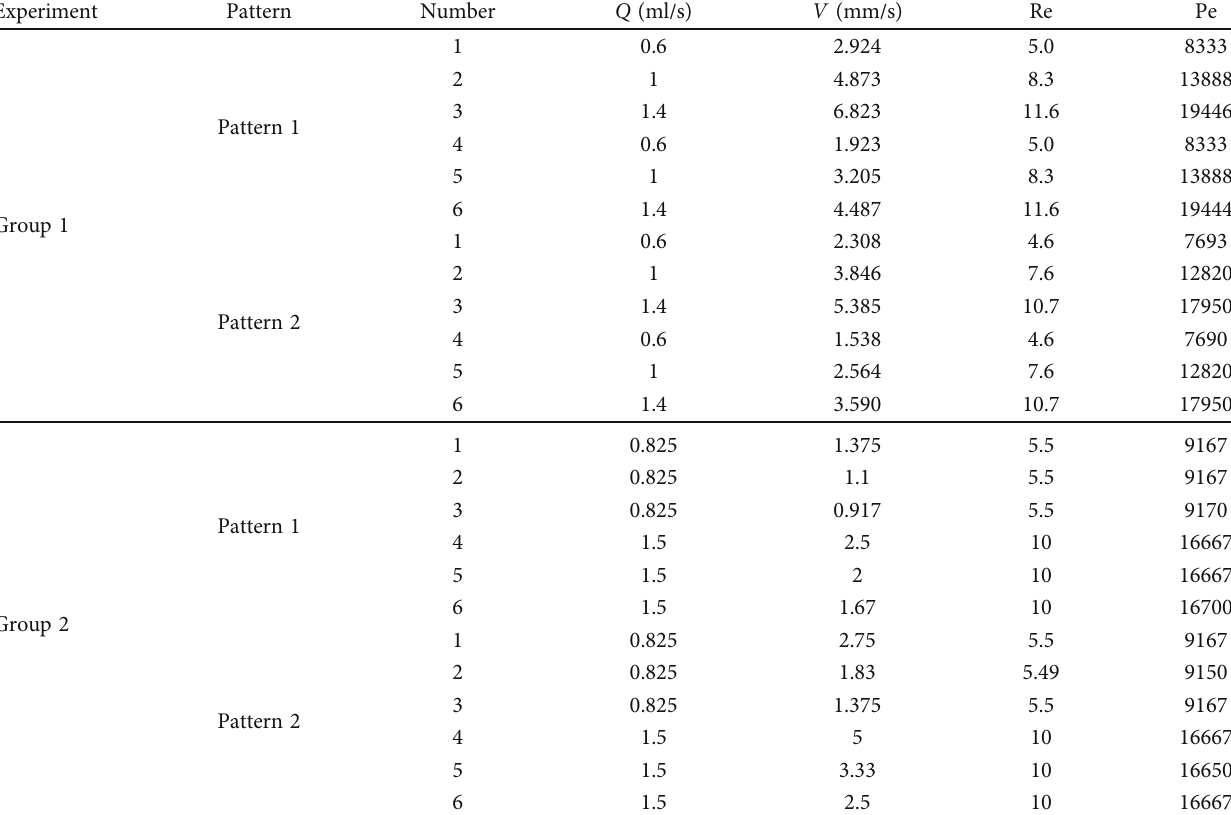
Table 2: Values of the Re and Pe versus Darcy ’ s velocity ( V ) with di ff erent fracture patterns. Experiment